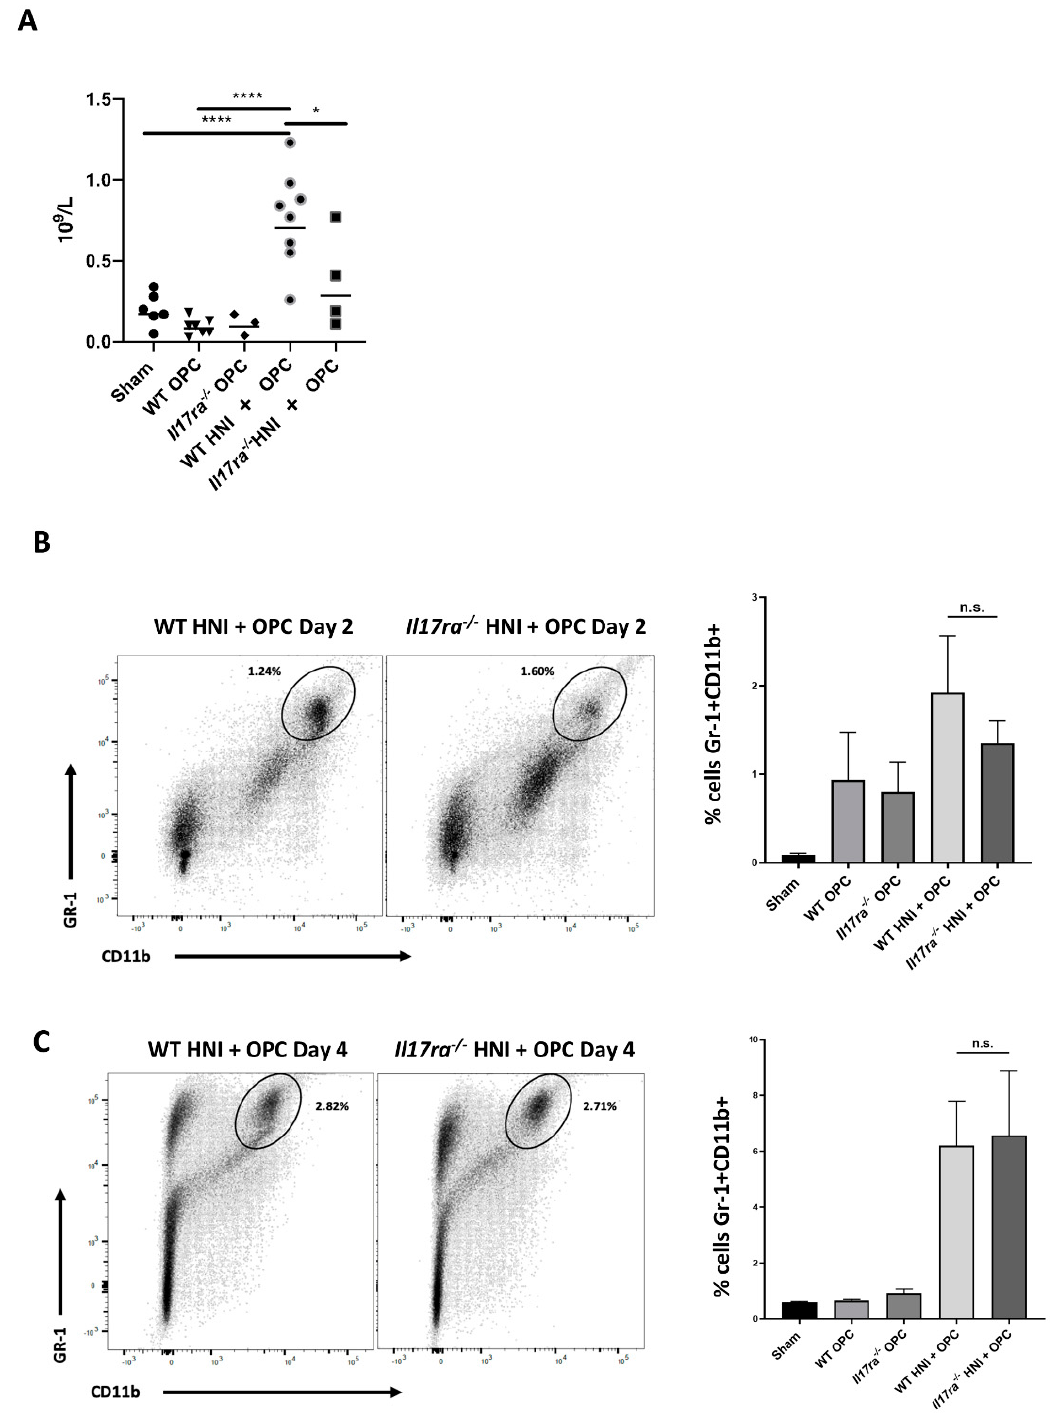
Figure 5. Heightened neutrophil recruitment in IL-17RA-deficient mice in response to OPC after HNI. ( A ) Cardiac puncture was performed to harvest blood from each mouse and the number of circulating neutrophils measured on Day 4 post-infection (n = 3 or more mice per group). ( B , C ) Flow cytometry performed on whole tongues harvested Day 2 and 4 after subjecting mice to OPC and HNI + OPC, followed by quantification of Gr-1 + CD11b+ neutrophils. (n = 3–6 mice per group). Analyzed by one-way ANOVA with Tukey’s post hoc. (* p < 0.05, **** p < 0.0001). Data represent 3 experimental repeats.